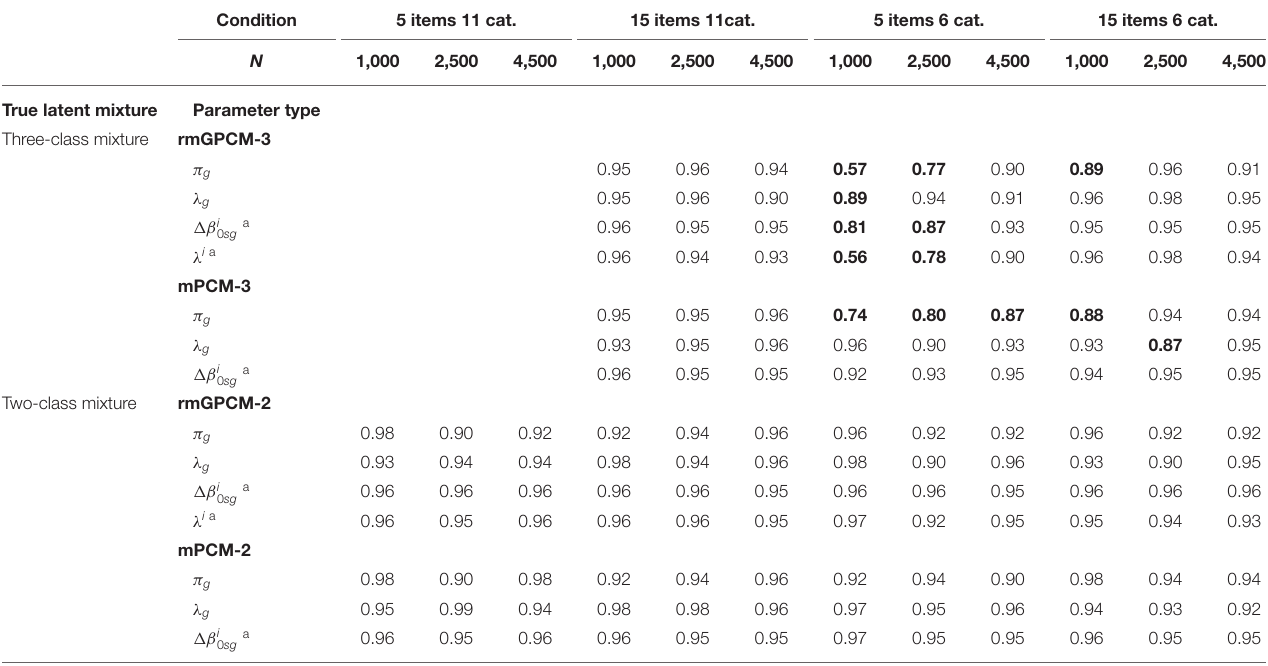
TABLE 6 | Mean coverage for the parameters of the rmGPCM and the mPCM under further data conditions.